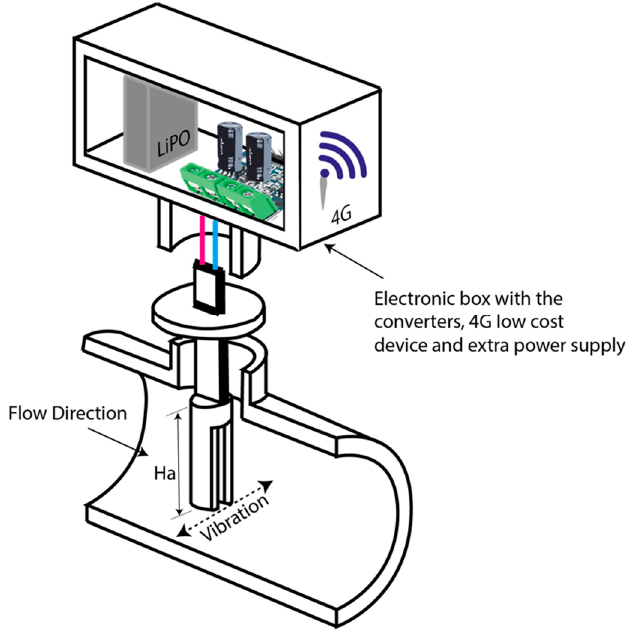
Figure 1. Water pipe with the U-shaped geometry assembled with the energy harvester as the oscillating body (not to scale). Ha—the length of the oscillating body.